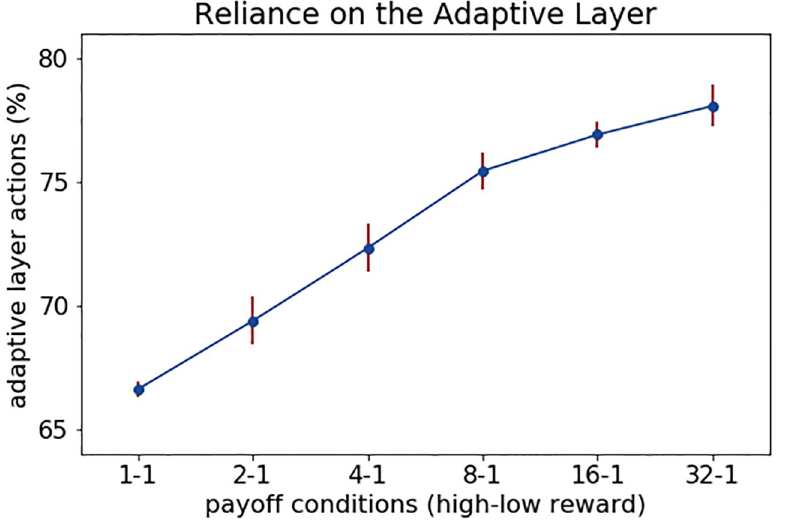
Fig 8. Reliance on the Adaptive Layer. Mean of the percentage of Adaptive Layer actions (ie. go to the high and go to the low actions) selected by the agents plotted against 6 conditions with an increasing difference between high and low payoffs. Bars reflect standard errors.